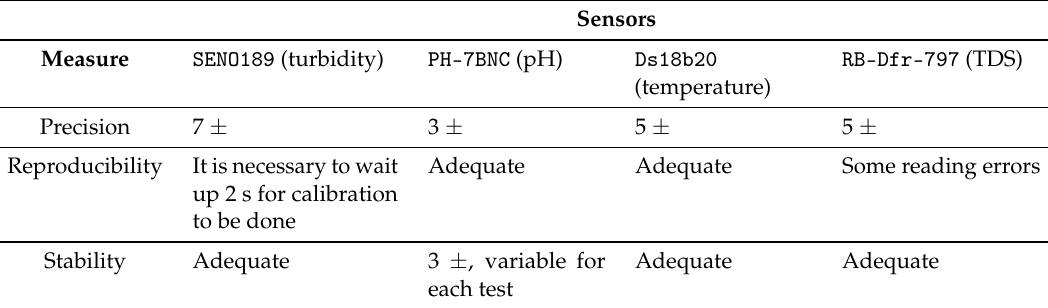
Table 1. Sensor performance